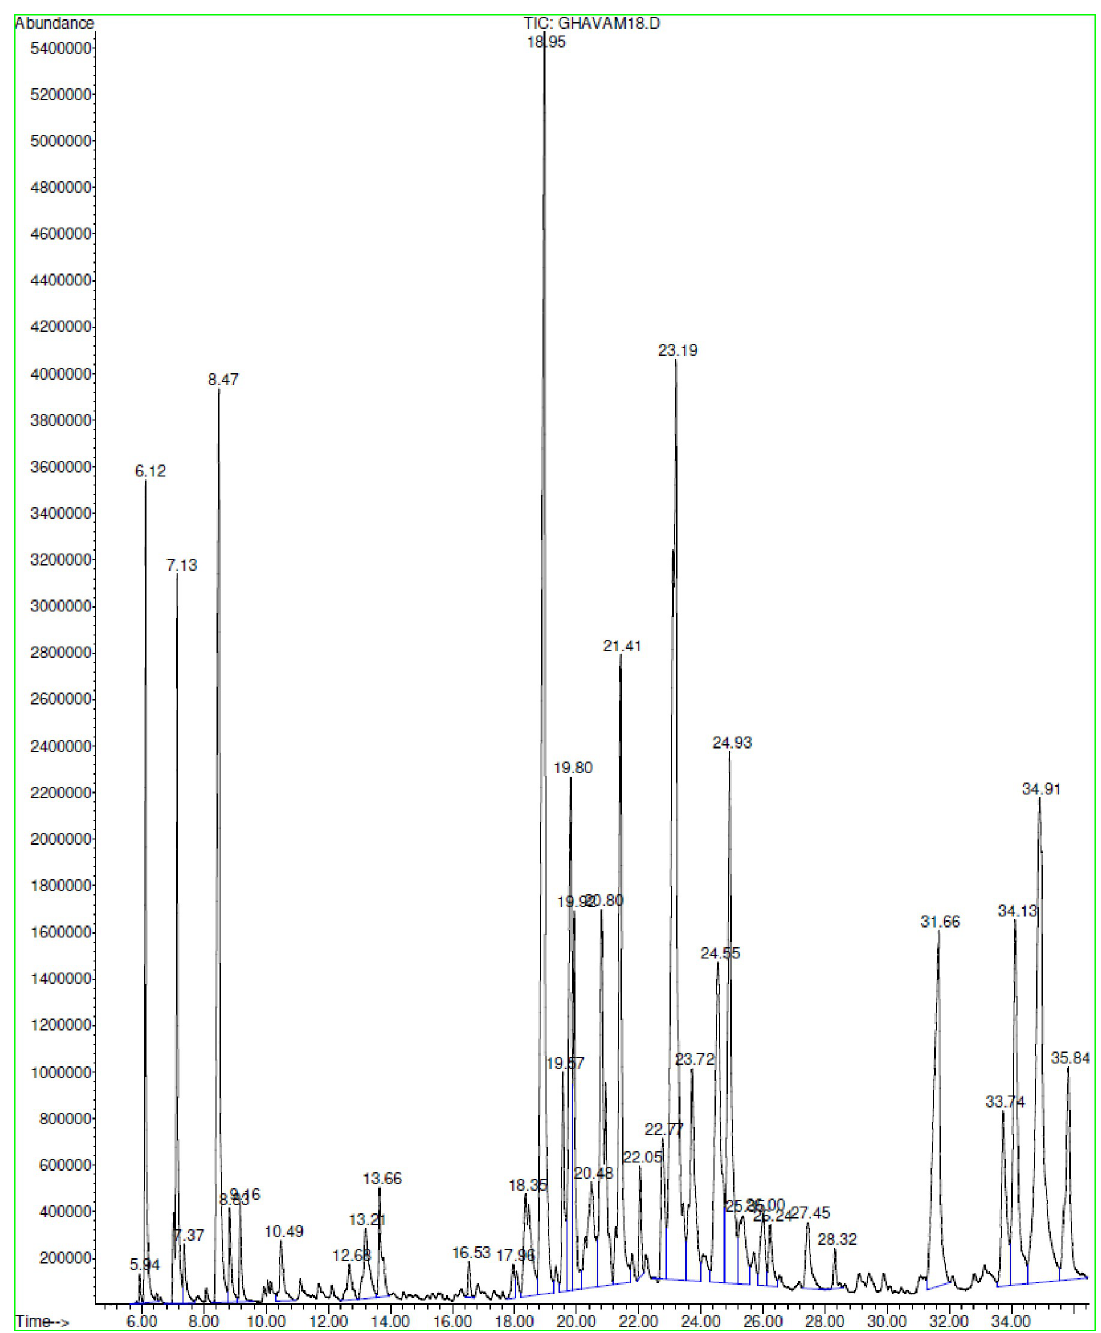
Fig 2. GC-MS chromatogram of essential oil of H . incanus